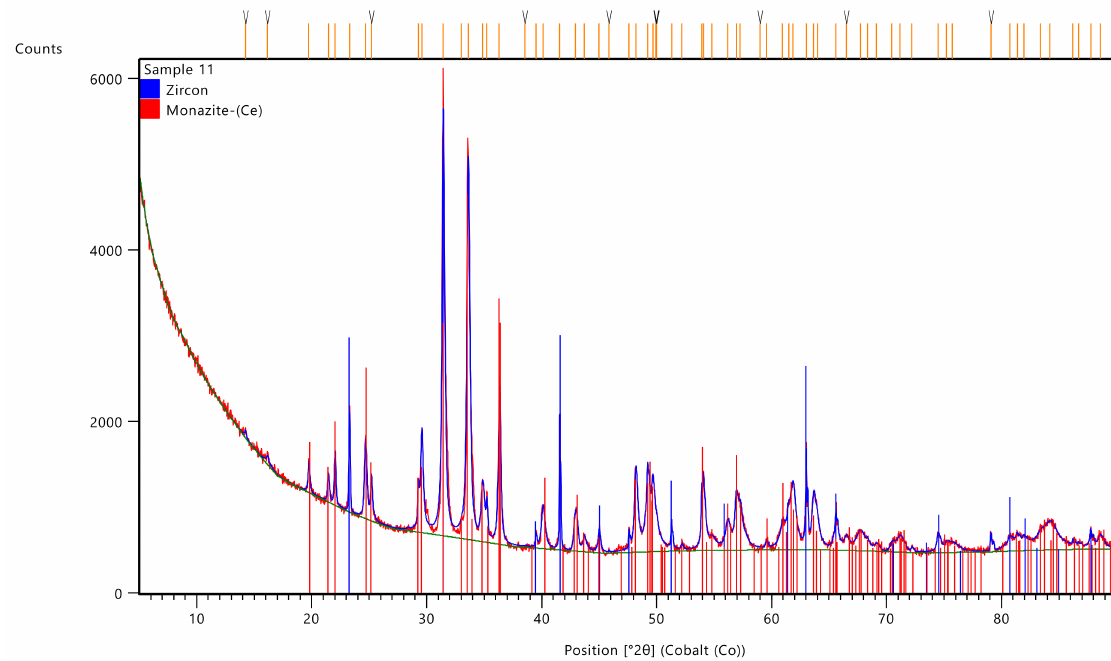
Figure 1. Perth monazite feed XRD output sample